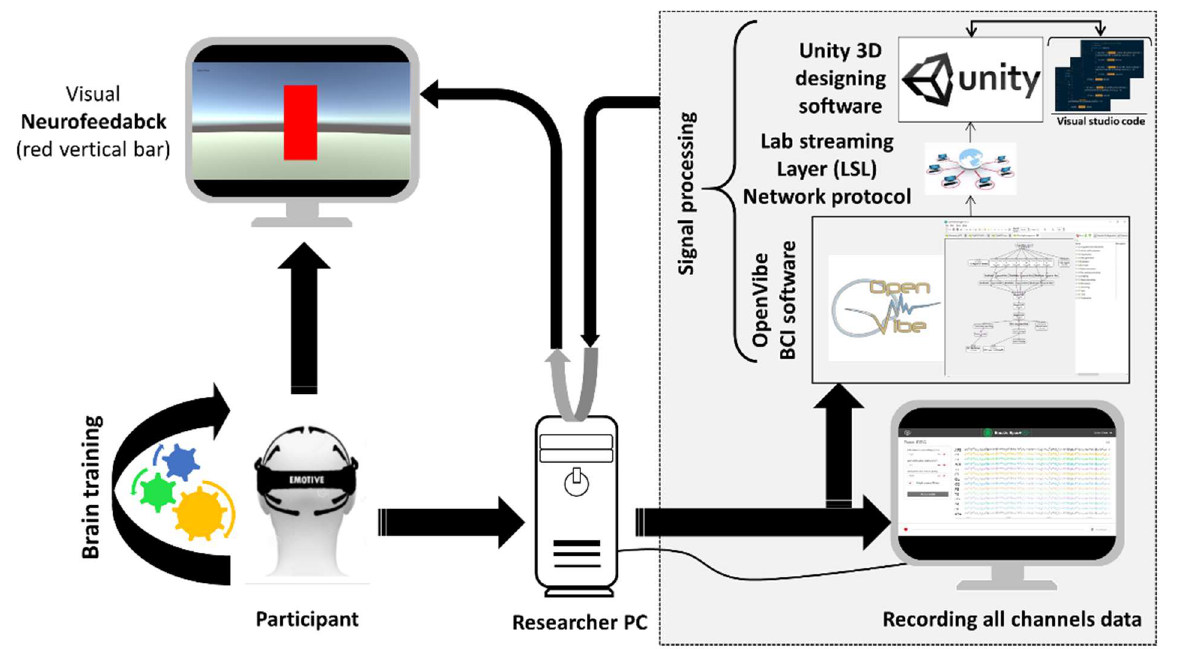
Figure 1. Design of the neurofeedback protocol. The red vertical bar represents the absolute value of alpha-band power.